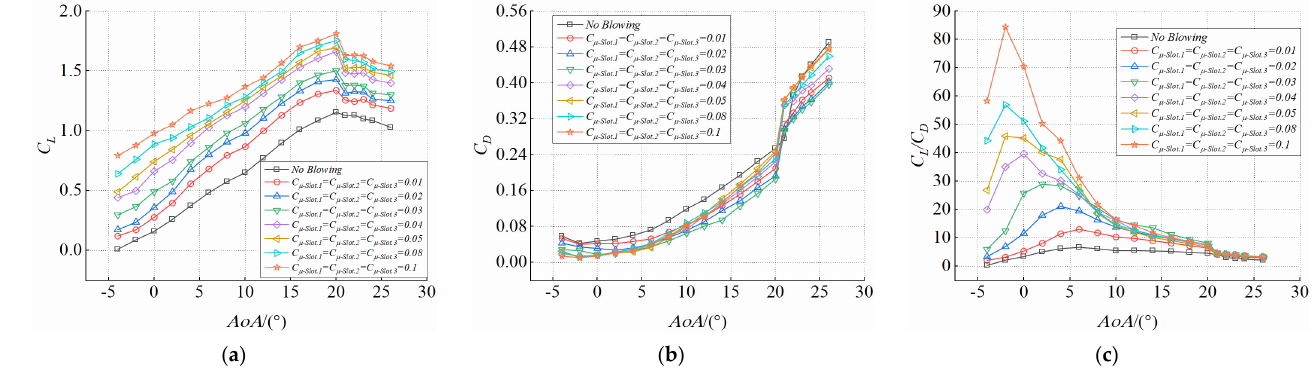
Figure 7. Aerodynamic curves of wing characteristics with different blowing coefficients ( U ∞ = 8 m/s). ( a ) Lift coefficient. ( b ) Drag coefficient. ( c ) Lift-to-drag ratio. As shown by the C L – C μ curve in Figure 8a, the wing lift coefficient gradually in- creased with the blowing coefficient; however, the slope of the lift coefficient curve de- creased after C μ-Slot. 1 = C μ-Slot. 2 = C μ-Slot. 3 = 0.04. As shown by the C D – C μ curve in Figure 8b, the drag coefficient did not monotonically decrease; instead, it increased after the blowing coefficient reached C μ-Slot. 1 = C μ-Slot. 2 = C μ-Slot. 3 = 0.03 and then finally flattened out. The C L / C D – C μ curve in Figure 8c shows that the slope of the lift-to-drag ratio curve reached the max- imum at a small angle of attack and tended to be gentle as the angle of attack gradually increased.